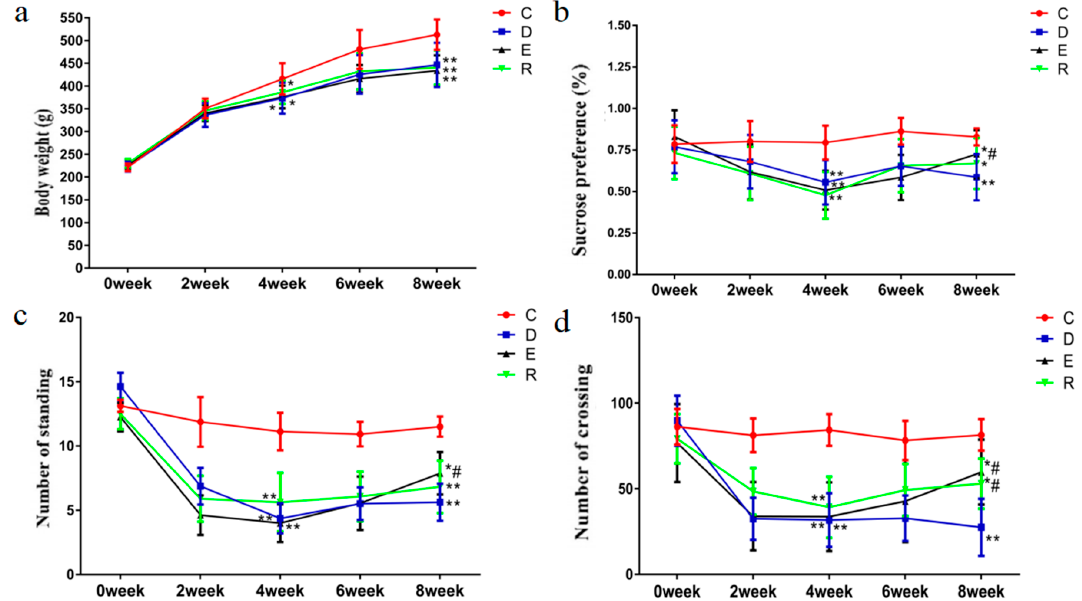
Figure 2. Effects of different exercise modes on behavioral indices of CUMS-induced depression rats. Comparison with group C: * p < 0.05, ** p < 0.01; comparison with group D: # p < 0.05, ## p < 0.01; ( a ) body weight, ( b ) sucrose preference, ( c ) number of standing, ( d ) number of crossing.